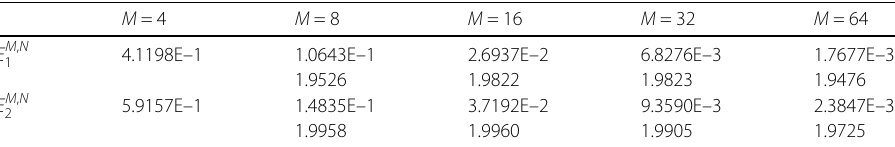
Table 3 E M , N and E M , N convergent results on spatial direction for L1 FEM with α = 0.4 1 2 M = 4 M = 8 M = 16 M =